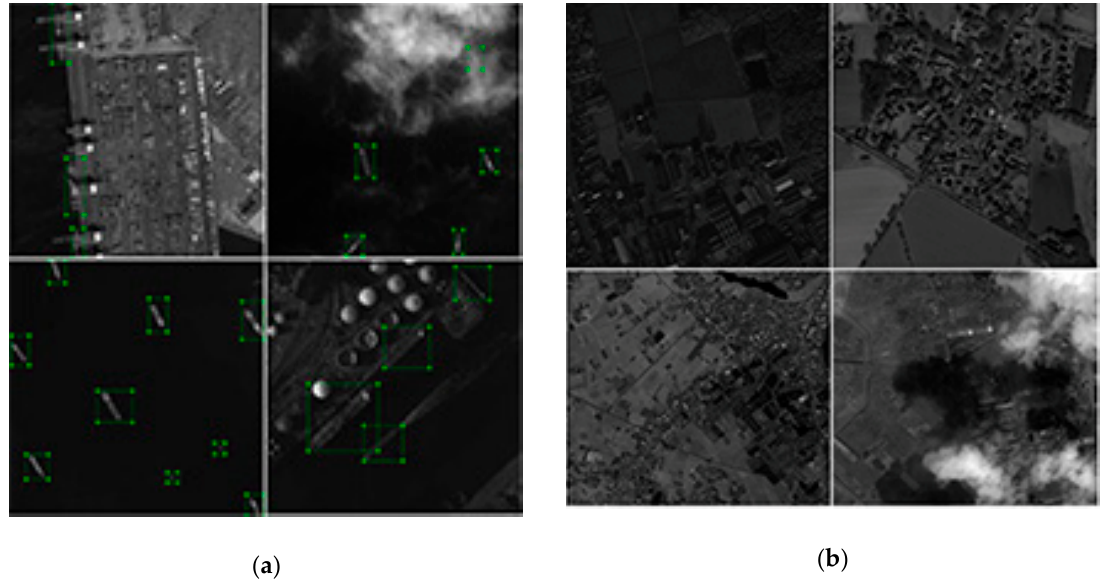
Figure 4. Positive sample images and negative sample images used in network training. ( a ) Positive sample images. ( b ) Negative sample images.